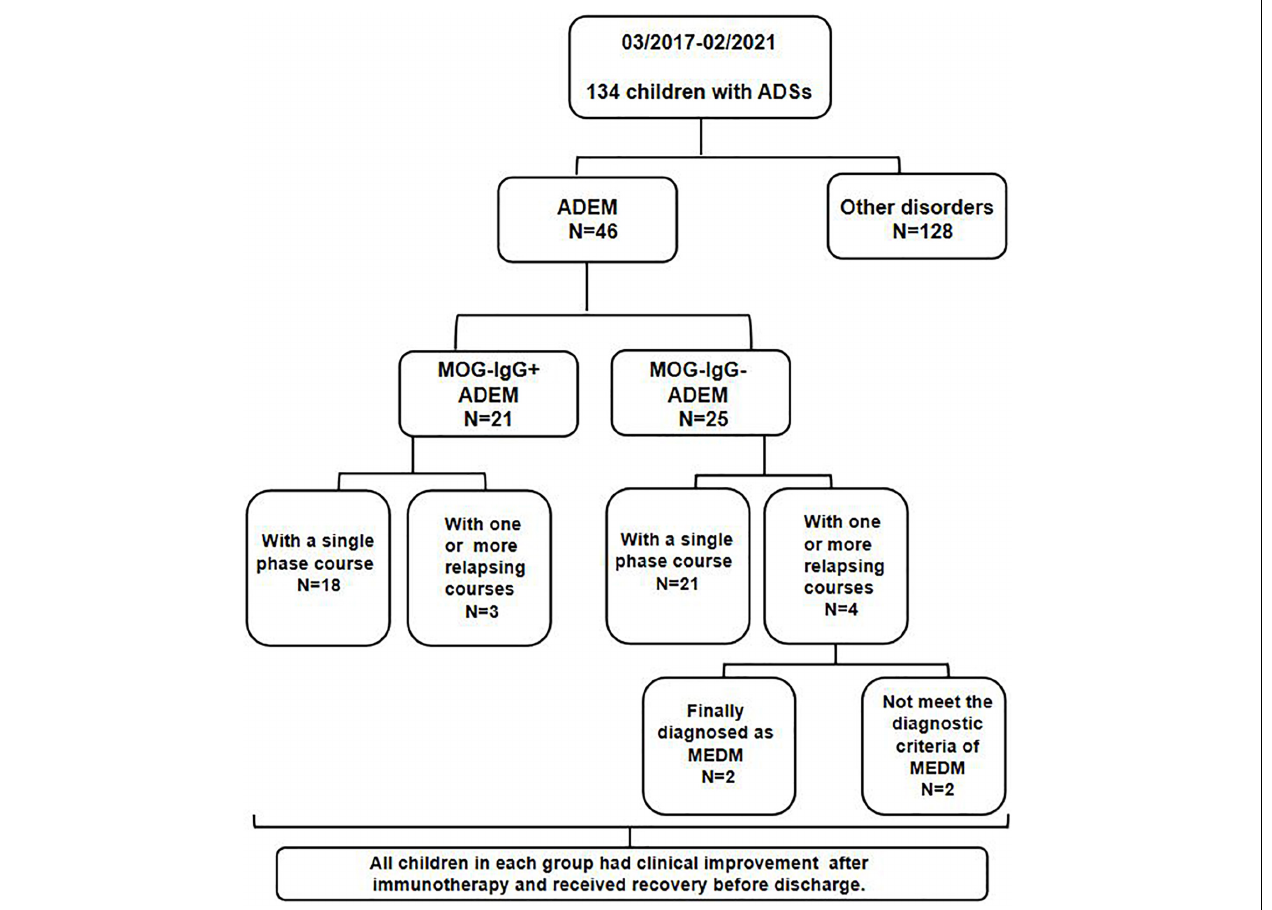
FIGURE 1 | Flowchart of samples and